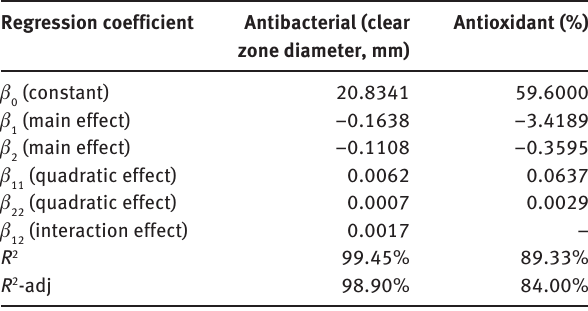
β is a constant, and β 0 and interaction coefficients of the quadratic polynomial equation, respectively.